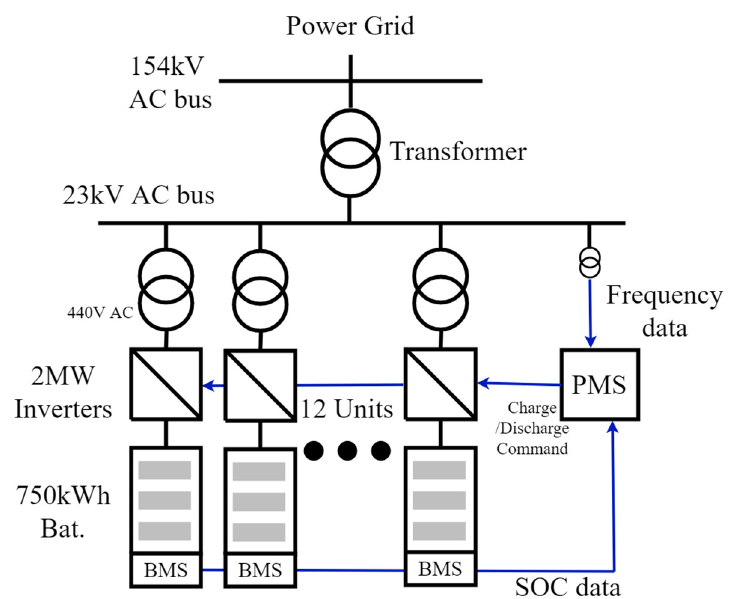
Figure 1. General energy storage system (ESS) structure for frequency regulation in KEPCO.